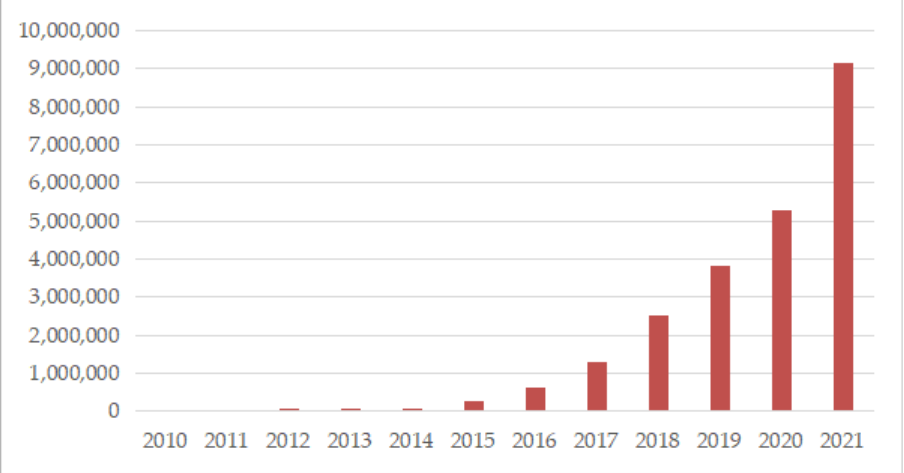
Figure 1. Accumulated sales of EVs in China, data source: MarkLines database.